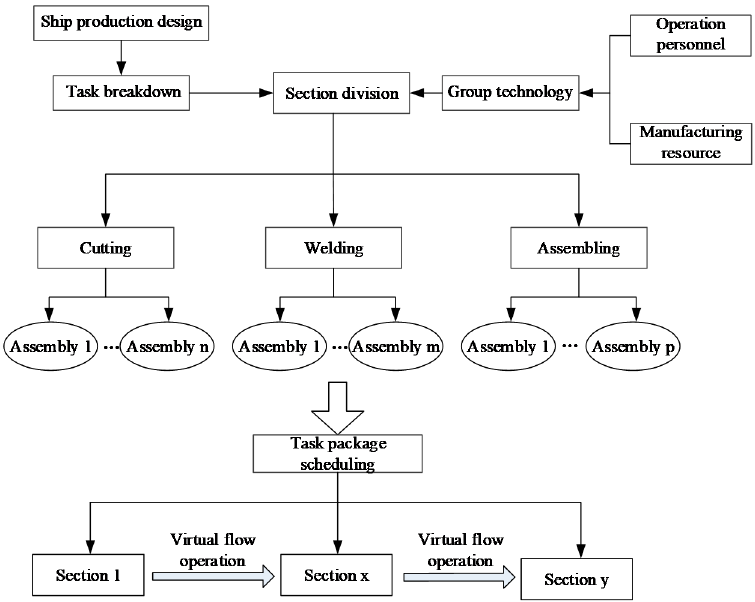
Figure 2. Schematic diagram of the virtual flow production system in shipbuilding